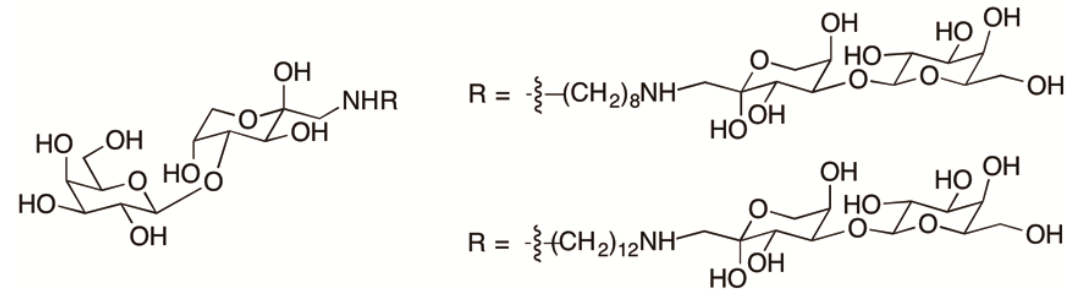
Figure 8. Lactulose amine dimers to target galectin-1.